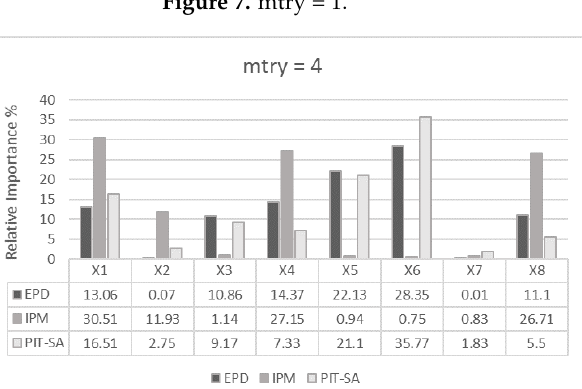
Figure 7. mtry = 1.